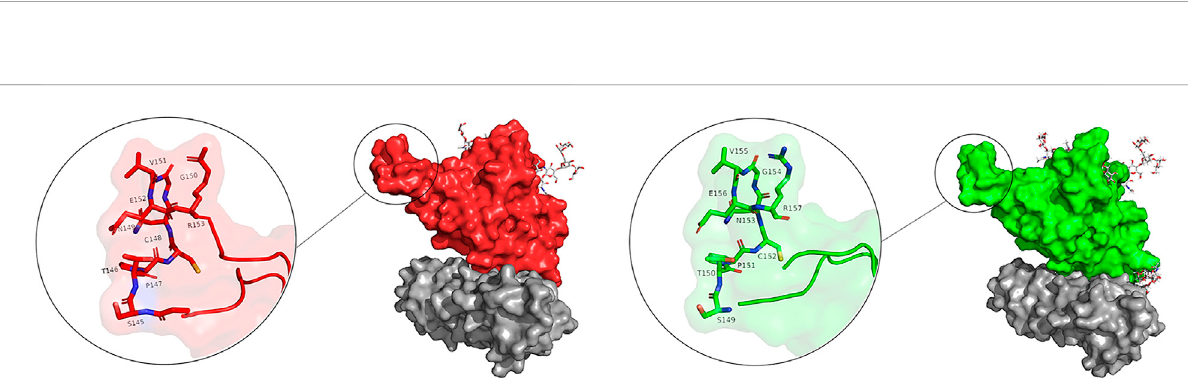
FIGURE 5 Flexible loopwithintheRBDstructureisshown inthesticks.Picture (A) shows thegRBDfN,andpicture (B) showsthegmRBDfN system.Ferritin is shown with a gray surface, and the RBD of gRBDfN and gmRBDfN are shown with red and green surfaces, respectively.